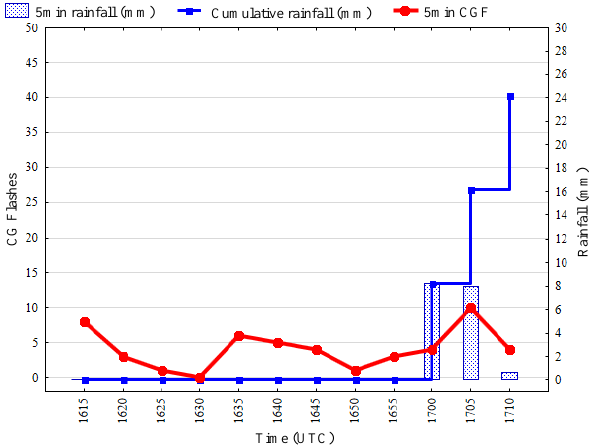
Figure 12. Critical interval time series for debris flow event of 19 July 2004. This is an event from the STH group and debris flow initiation was observed at 17:30UTC.